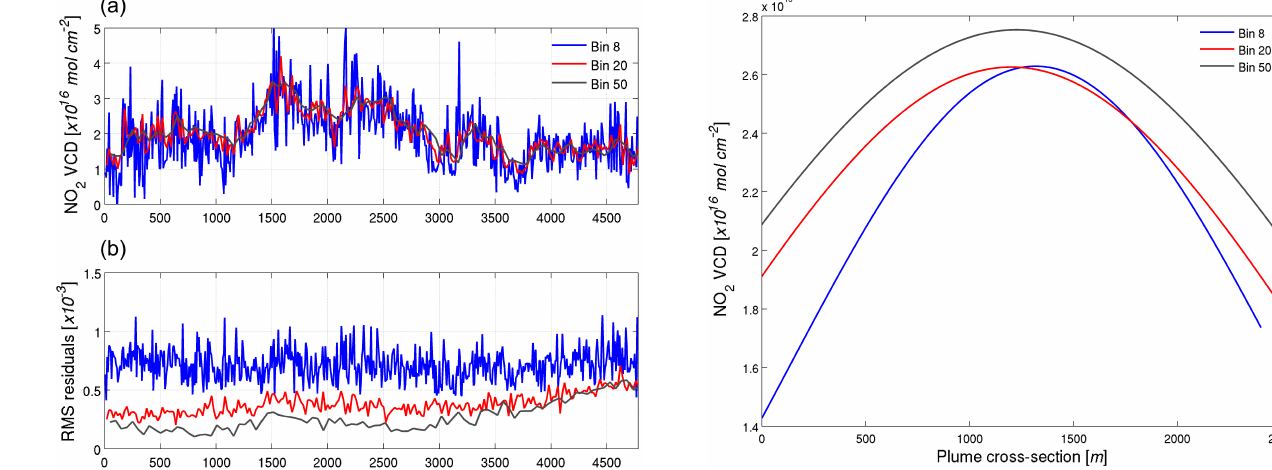
Figure 5. Gaussian model fit to the NO 2 VCDs of a 2500m hori- zontal profile, perpendicular to a major industrial NO 2 plume, for three different binning levels, i.e. 8 2 , 20 2 and 50 2 pixels. Table 3. APEX spectral performance for the NO 2 calibration win- dow. Both nominal (laboratory performance) and effective (in- flight performance) parameters are provided. Due to the wavelength and pixel-location dependency, FWHM and shift are provided for 490nm, i.e. the middle of the analysis window, and for the nadir- looking detector pixel of the pushbroom